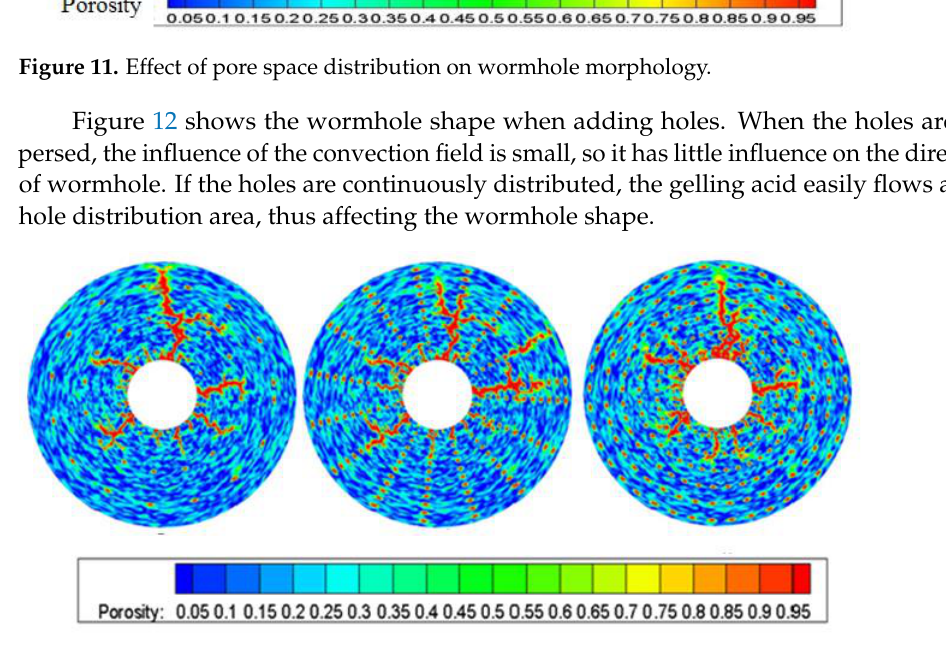
Figure 12. Effect of hole distribution on wormhole expansion.